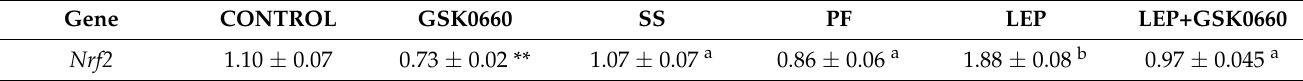
Table 4. Gene expression of Nrf2 in epididymal white adipose tissue.